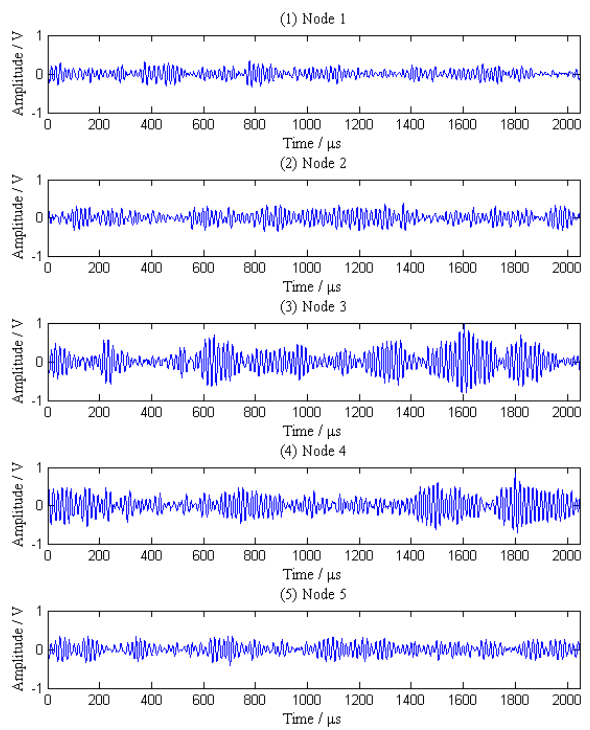
Figure 6. Original signals received by five sensor